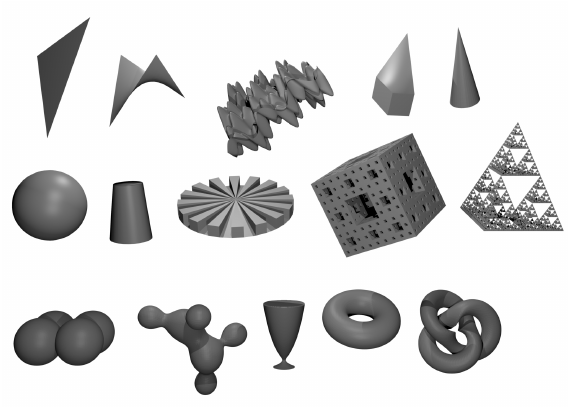
Figure 1. Basic scene objects from top left to bottom right: triangle, quadrilateral, sine wave, curved box, cone, sphere, truncated cone, Boehler star, Menger sponge, Sierpinski tetrahedron, 4- and 6-metaballs, wine glass, torus, trefoil knot. For naturally-looking objects like mountainous landscapes or sea, additively modulated sine waves are derived from a quadri- lateral grid. The coordinates of the subdivision points of its inner surface are altered according to equation